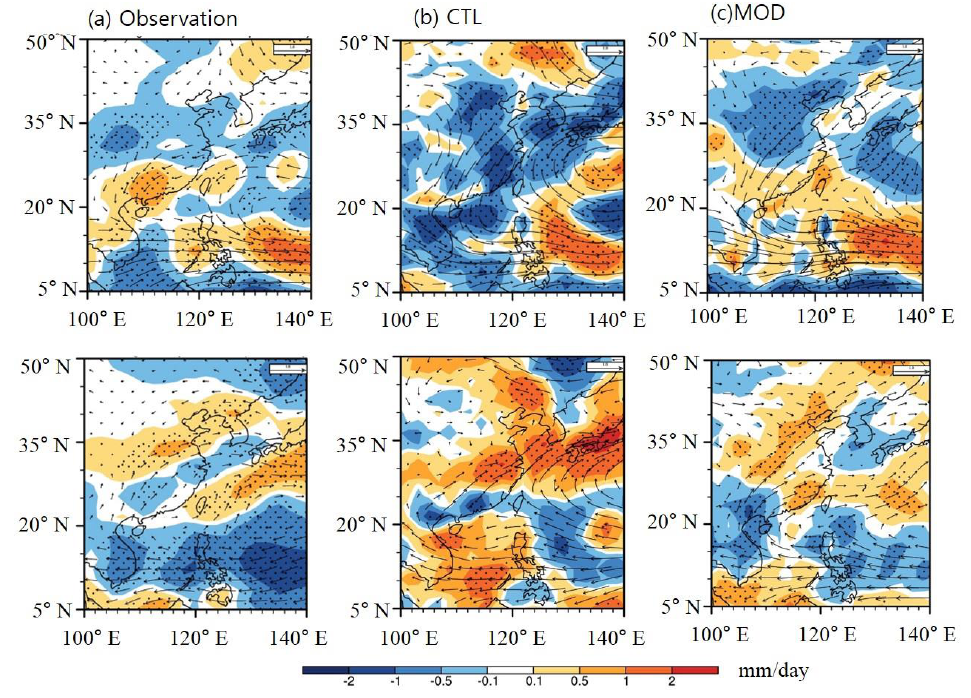
Figure 10. Composite maps of JJA rainfall (shading, mm day − 1 ) and 850 hPa winds (vector, m s − 1 ) anomalies from: ( a ) observation; ( b ) CTL; and ( c ) MOD during El-Nino developing (upper panels) and decaying year (lower panels). The only significant areas are dotted (95%) (Ambaum 2010).